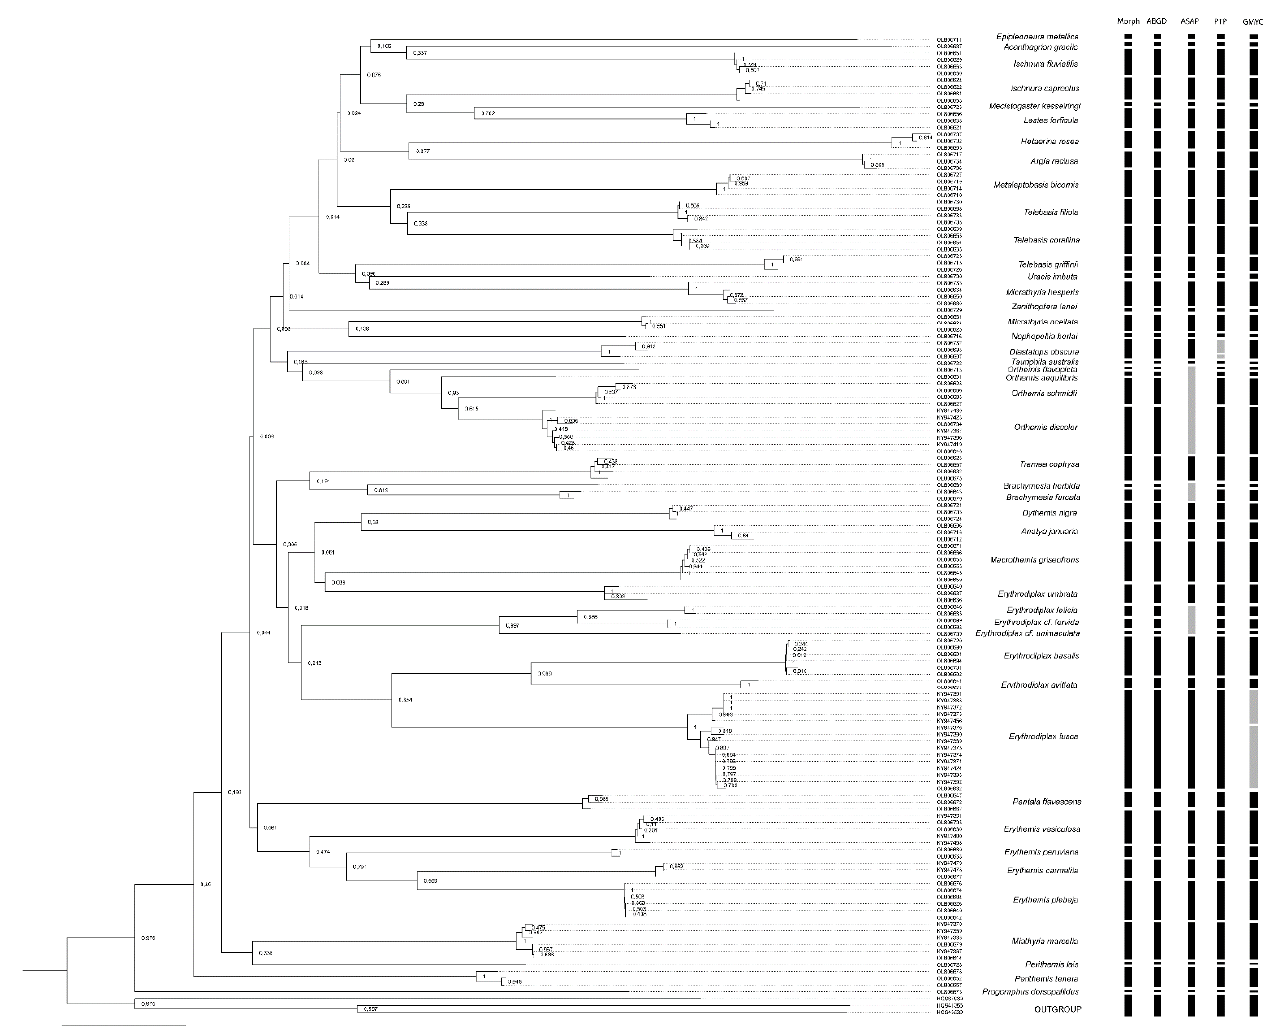
Figure 4. Molecular species delimitation of odonates from the Paraíba state, Brazil, based on DNA barcodes. Black bars indicate congruent results between the molecular and morphological identifications, and grey bars indicate divergence results from morphological identification. It should be noted that the neighbor-joining tree presented here is only intended to represent the distance matrix, and it should not be interpreted as a phylogenetic hypothesis.